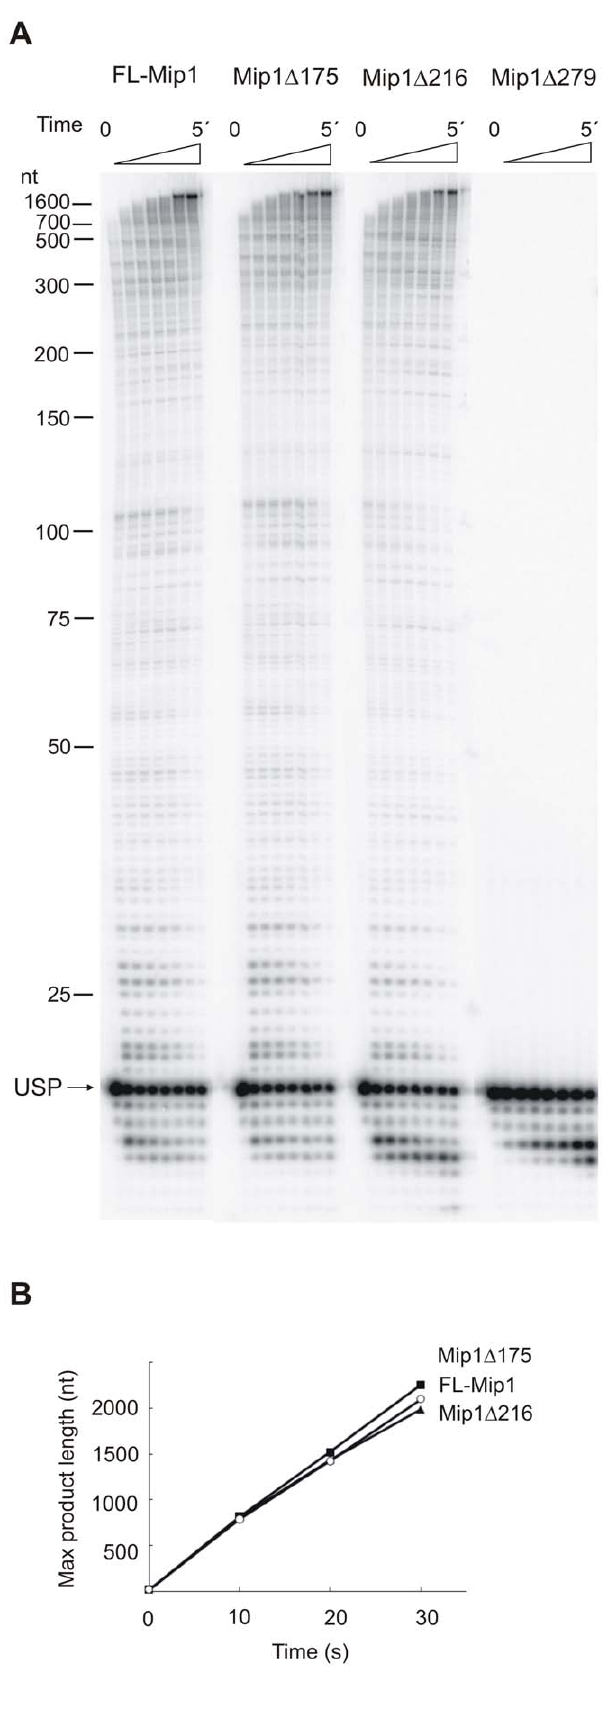
Figure 3. DNA polymerase activity of Mip1 and C-terminal deletion mutants. DNA polymerase activity was measured using 40 nM DNA polymerase, 4 nM M13 circular ssDNA singly primed with radiolabeled USP primer and 100 m M dNTP. The reaction was carried out at 30 u C and stopped after 0 s, 10 s, 20 s, 30 s, 45 s, 1 min, 2 min and 5 min with equal volume of 80% deionized formamide, 25 mM EDTA. A. Reaction products were resolved on 8% denaturating polyacrylamide gel. The position of 17 nt USP is marked with an arrow. B. Maximum product length was determined using the DNA marker as a standard and plotted against time. FL-Mip1 – empty circle, Mip1 D 175 – filled square, Mip1 D 216 – filled